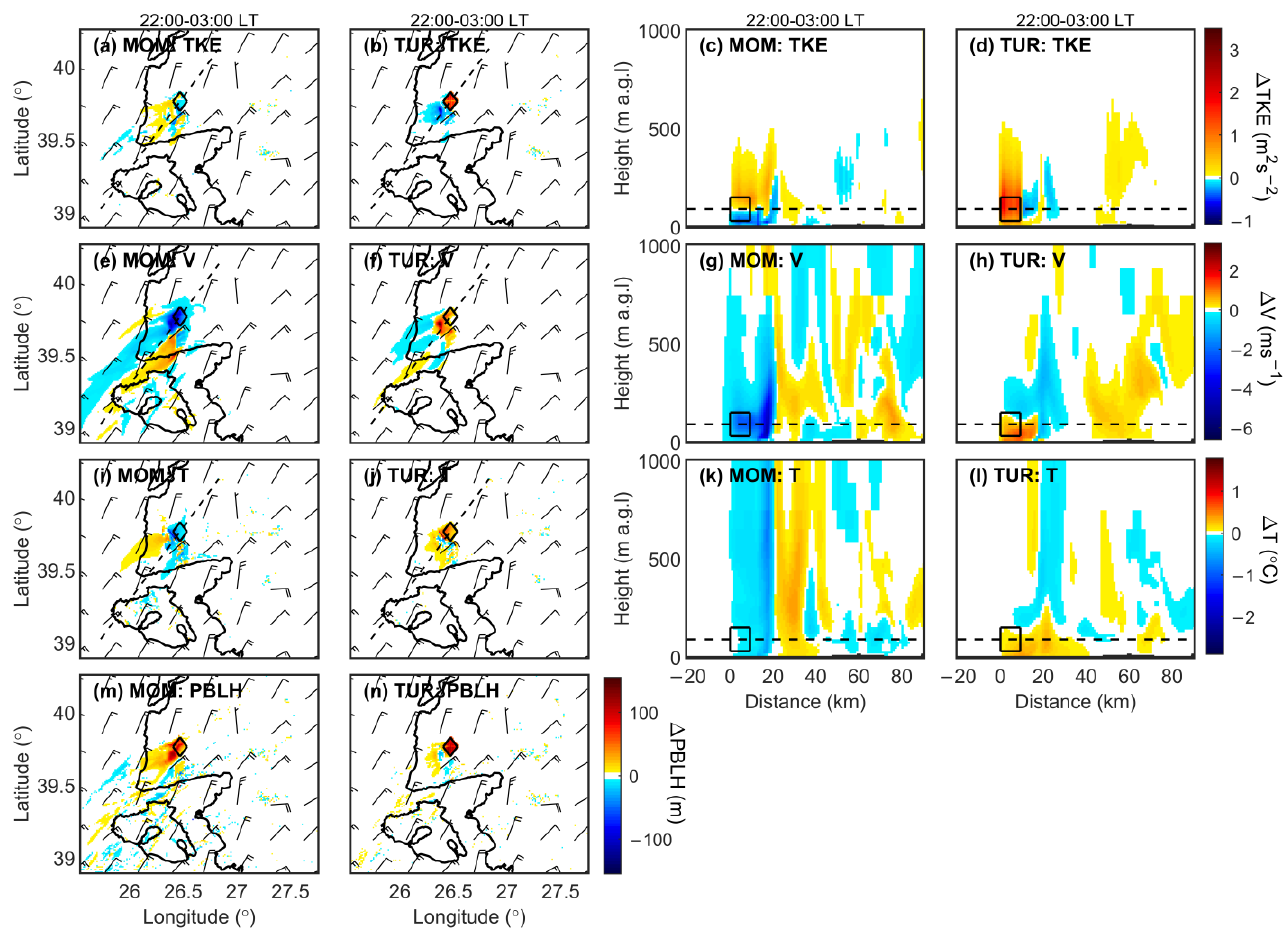
Figure 7. Impacts of the WFP’s momentum tendency (MOM) and TKE tendency (TUR) components on boundary layer variables such as TKE, wind speed (V), air temperature (T), and PBLH from both horizontal cross-sections in the left panel ( a , b , e , f , i , j , m , n ) and vertical cross-sections in right panel ( c , d , g , h , k , l ). These simulations use the model configuration of the BASE simulation. Wind barbs from the WRF-WFP simulation are plotted in knots for every 27 km; a thick black line represents coastlines; a thin dashed black line crossing the wind farm represents a vertical cross-section line; a square box in the left panel represents the wind farm area; the box in the right panel represents the rotor area of the wind farm; and the dashed horizontal line represents the hub height of the wind turbine.